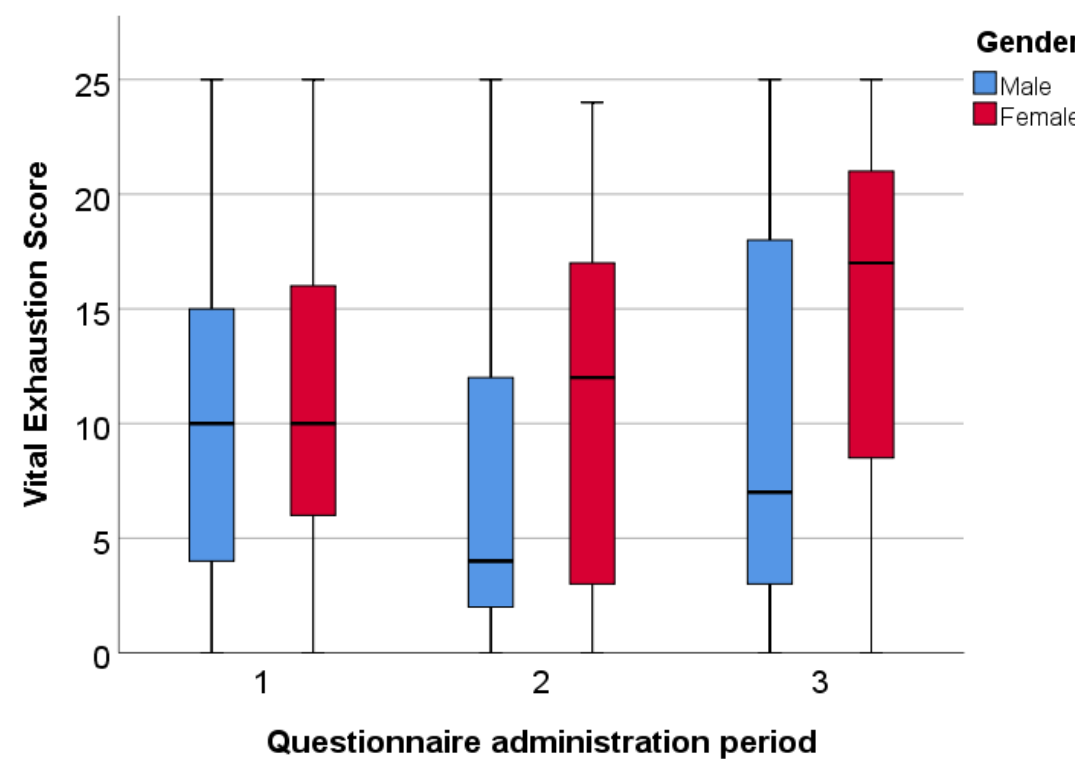
Figure 5. Gender differences in vital exhaustion among international students.